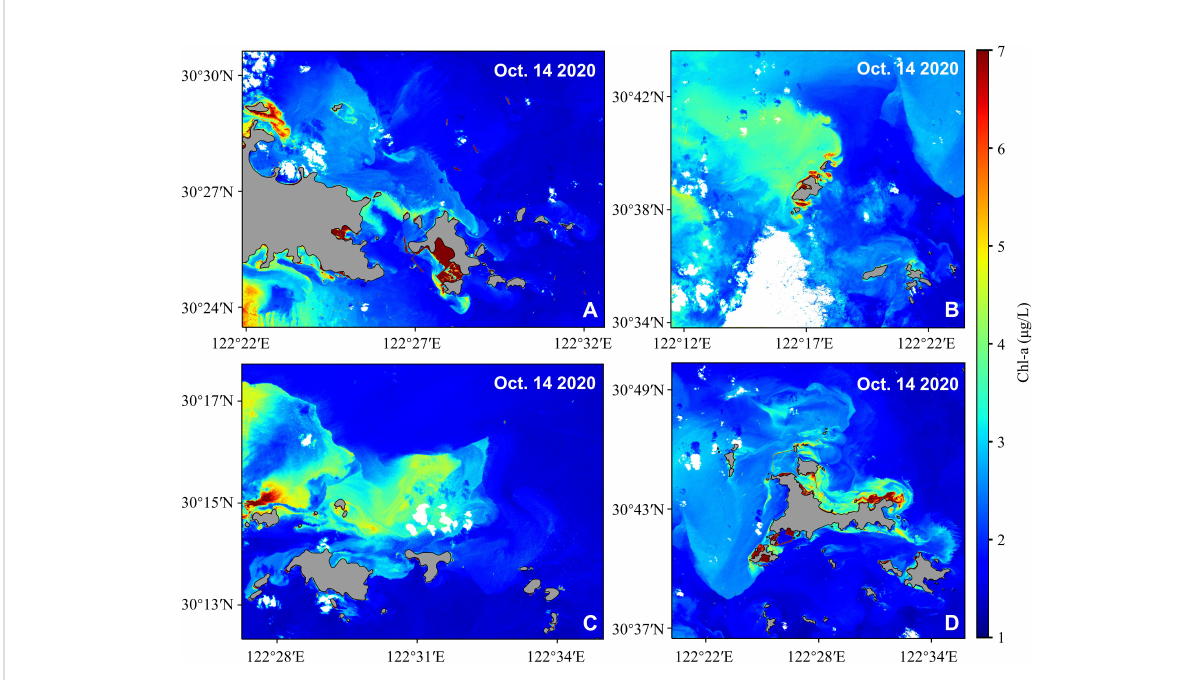
FIGURE 5 Chl- a concentration distribution details around the water of Zhoushan archipelago. Chl- a distribution in the fi gure is taken from the GF-6/PMS image on 14 October 2020 and the Chl- a concentration retrieved based on the new model of PMS-Chla. (A) The Qushan Islands; (B) the Chuanhu archipelago; (C) the Xizhai and Dongzhai Islands; (D) the Shengsi